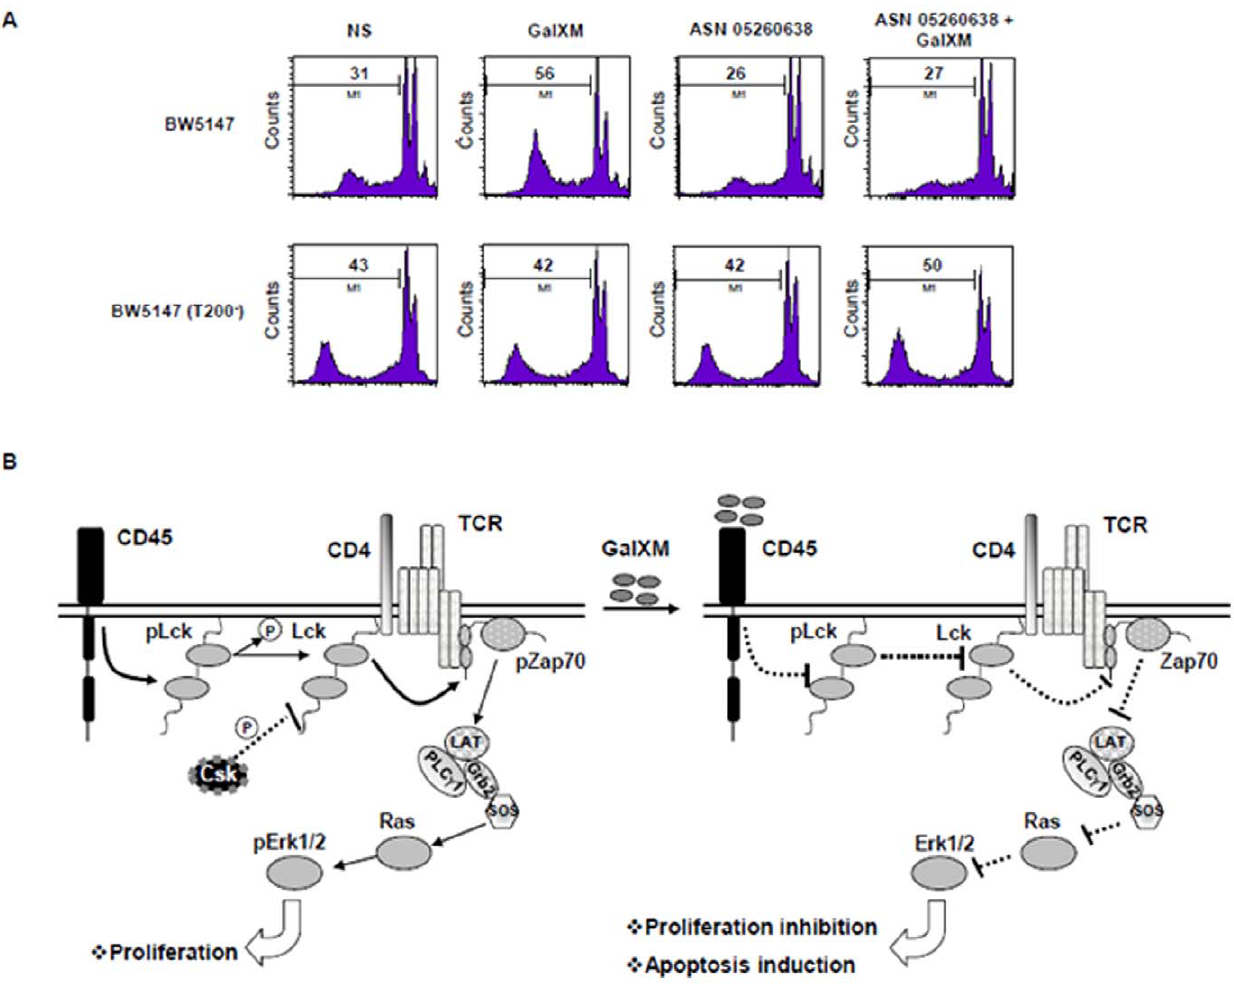
Figure 7. Blocking of CD45 phosphotase activity induces apoptosis and inhibits proliferation of BW5147 cells treated with GalXM. ( A ) BW5147 and BW5147 (T200 2 ) cells (both 1 6 10 6 /ml) were pre-treated for 10 min with ASN 05260638 (20 m M) and then incubated for 18 h in the presence or absence (NS) of GalXM (10 m g/ml). After incubation, the percentage of cells undergoing apoptosis was evaluated by PI staining and analyzed using FACScan flow cytometry. Data are expressed as FACScan histograms from one representative experiment out of five with similar results. ( B ) Schematic representation of GalXM effect on BW5147 cells. GalXM induces immunosuppressive effects on T cells through Lck inactivation. This effects occurs after GalXM association to CD45, which inhibits its dephosphatase